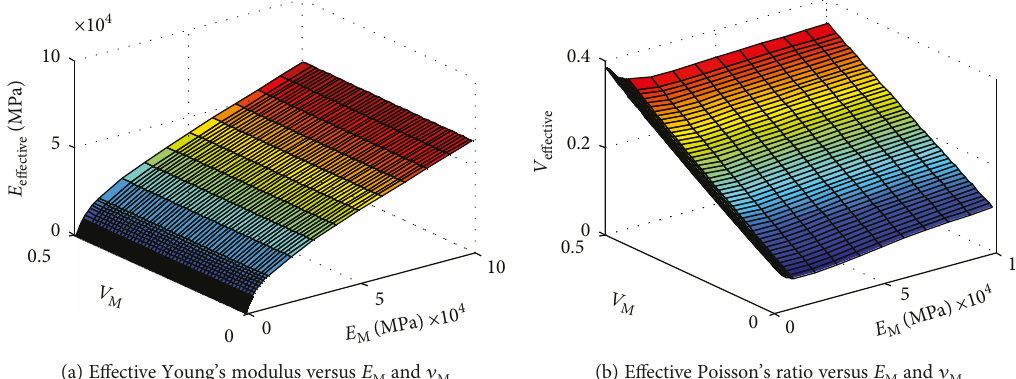
Figure 9: E ff ective properties of solid propellants versus E